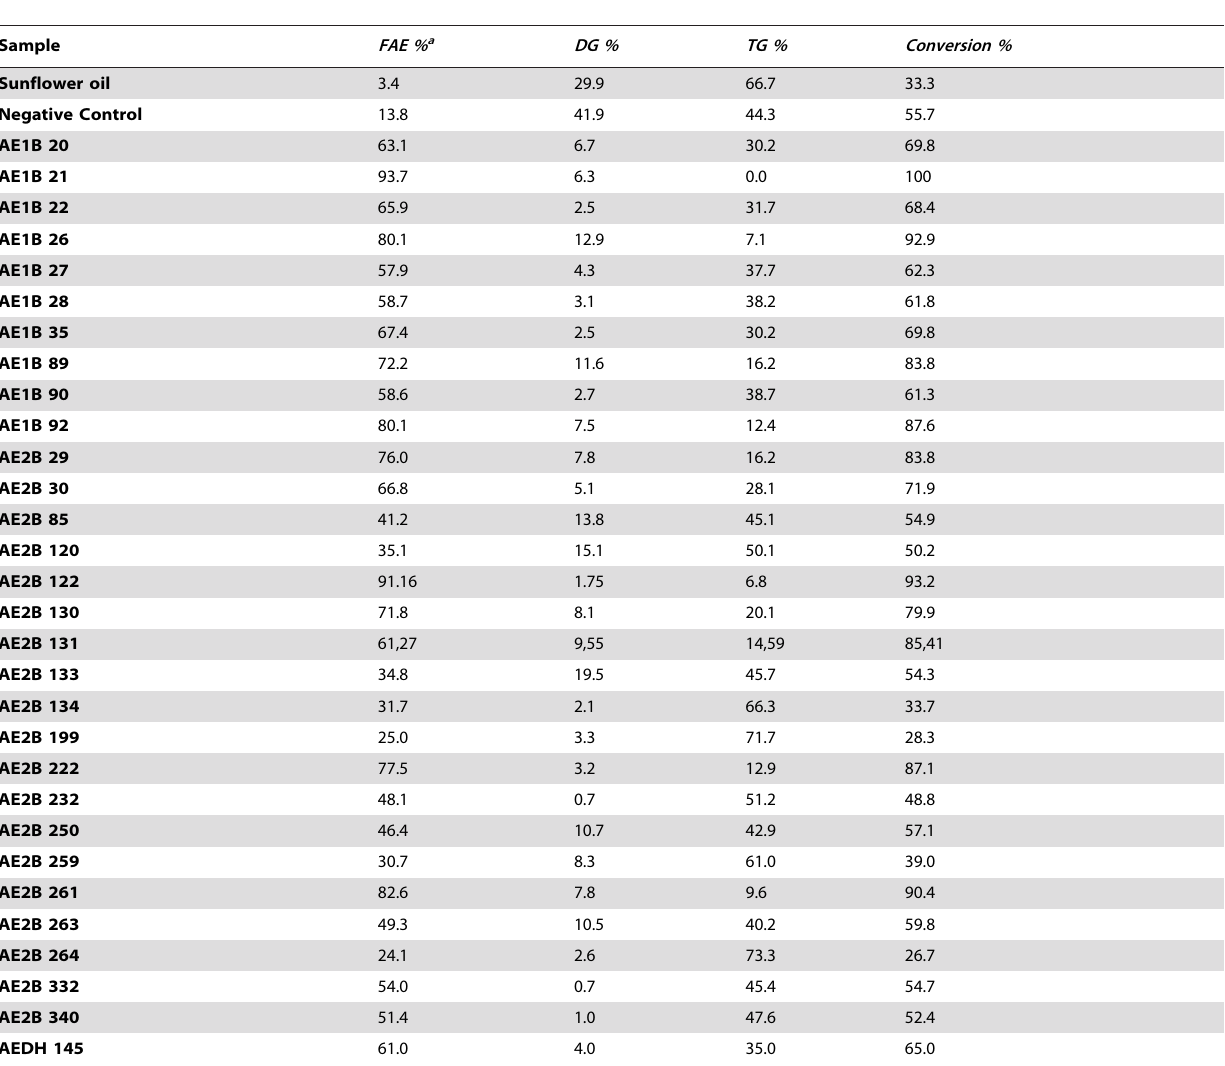
Table 4. Transesterification reaction of sunflower oil by the bacterial extracts determined by GC analysis.